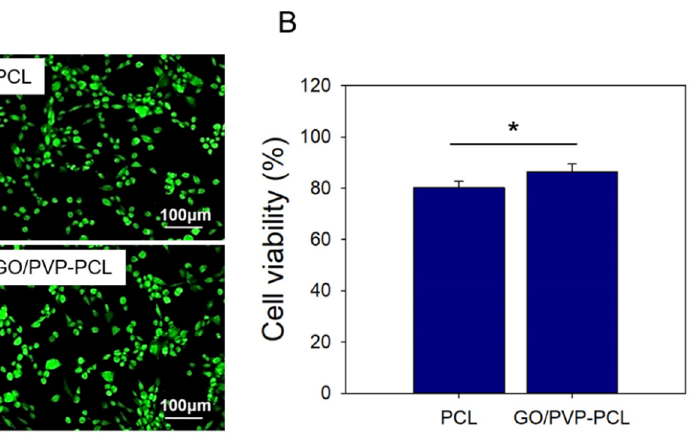
Figure 5. In vitro cytocompatibility of PCL and GO/PVP-PCL: ( A ) Live/Dead assay; ( B ) CCK assay. “*” Indicates statistical significance relative to the PCL ( p < 0.05).